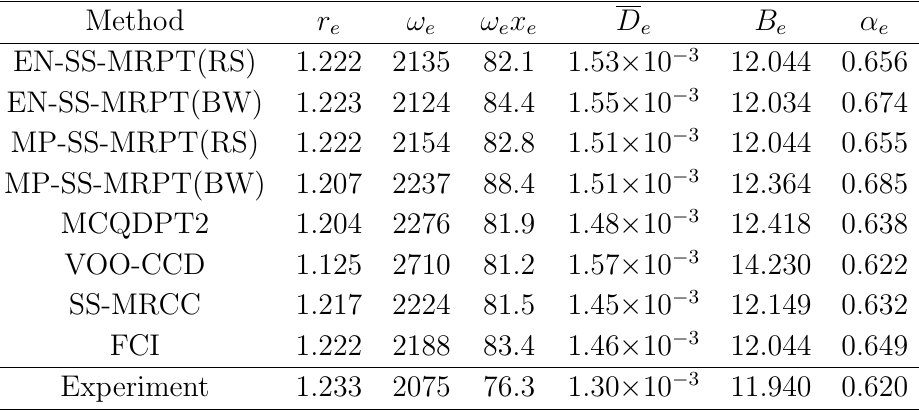
Table 2: Spectroscopic constants for the first 1 ∆ state of CH +